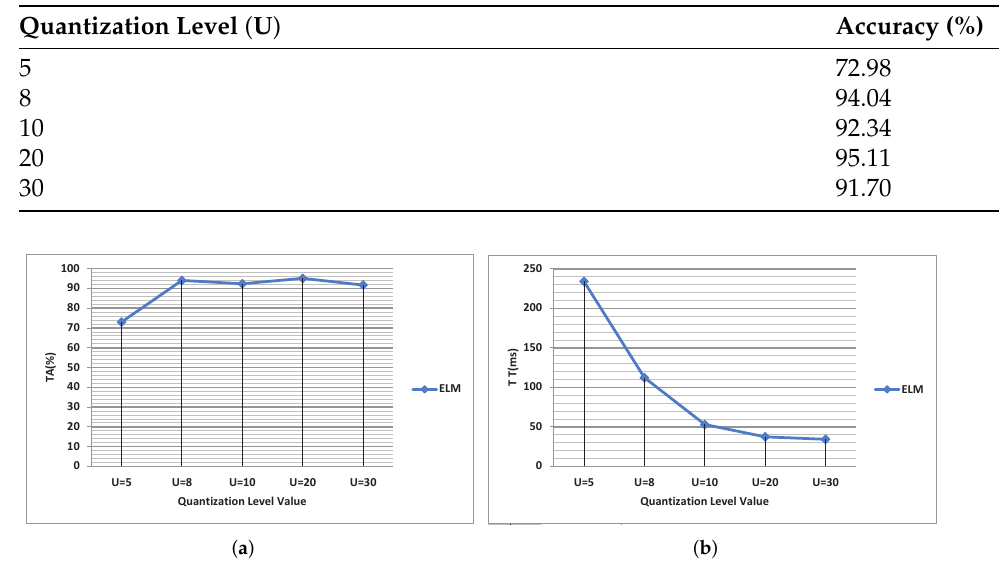
Table 2. Variation of the TA with the Quantization Level.